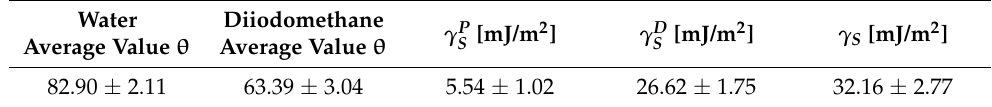
Table 1. The surface free energy for the Kap 7 sample.